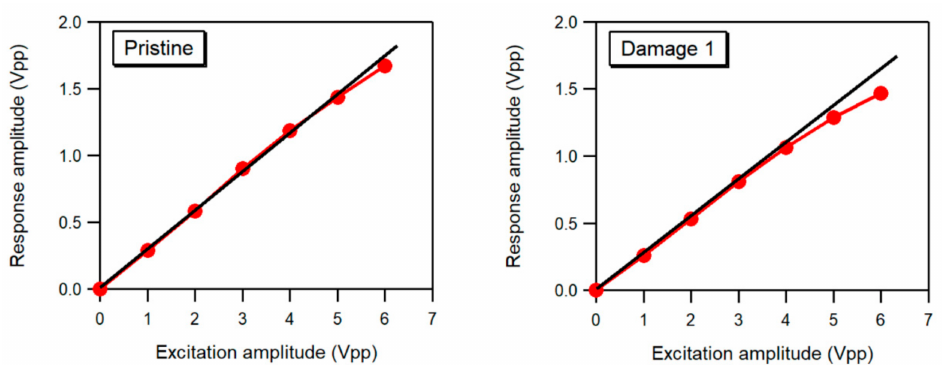
Figure 5. Response amplitude vs. excitation amplitude for the ( a ) pristine and ( b ) damaged case, recorded at sensor S1 under harmonic excitation of frequency 3915